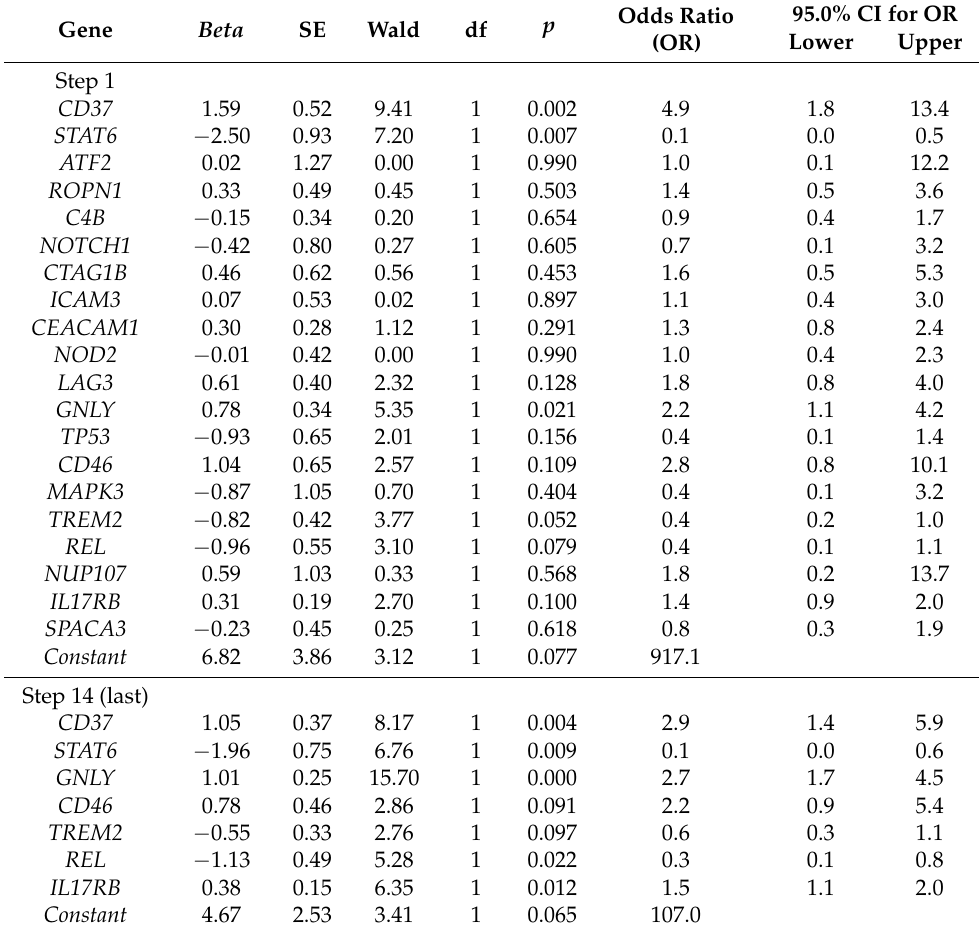
Table 5. Associations between the top 20 genes identified by the multilayer perceptron and molecular subtypes (GCB,